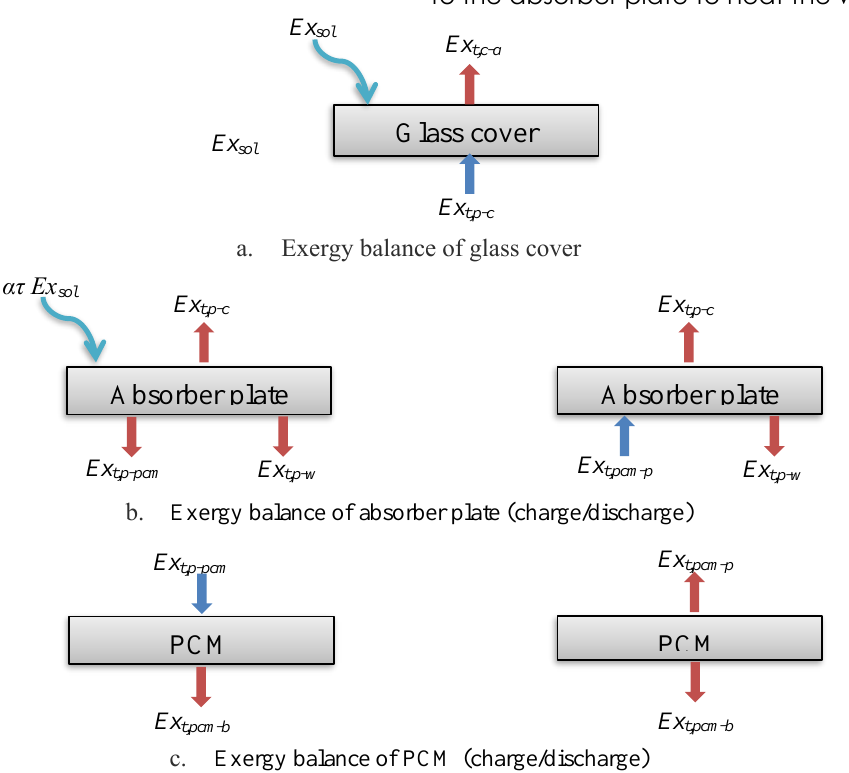
Figure 2. Exergy balance of the solar collector